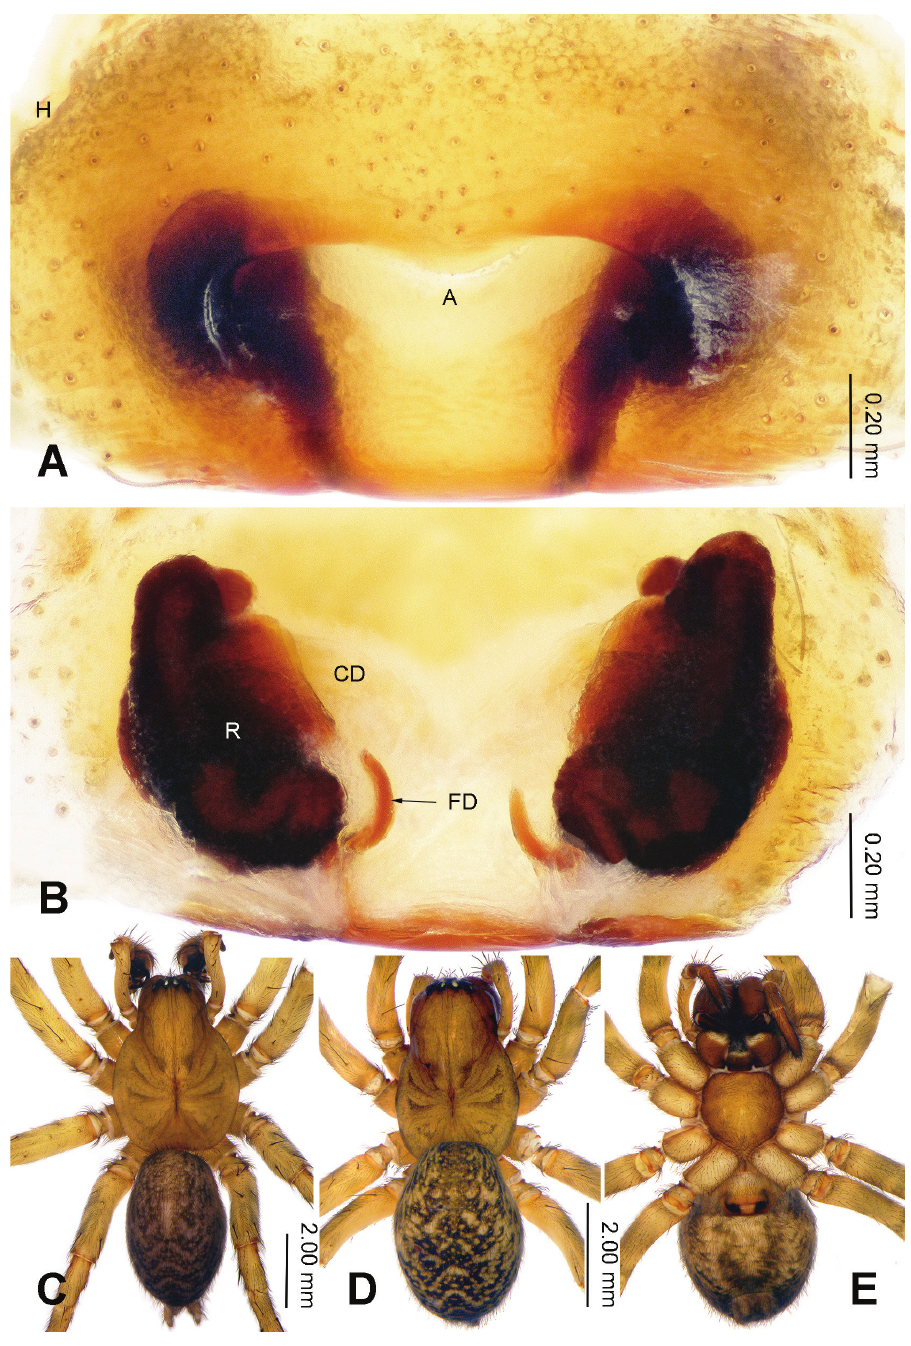
Figure 4. Epigyne and habitus of Sinodraconarius cawarongensis sp. n. A Epigyne, ventral B Vulva, dorsal C Male habitus, dorsal D Female habitus, dorsal E Female habitus, ventral. Scale bar equal for D and E